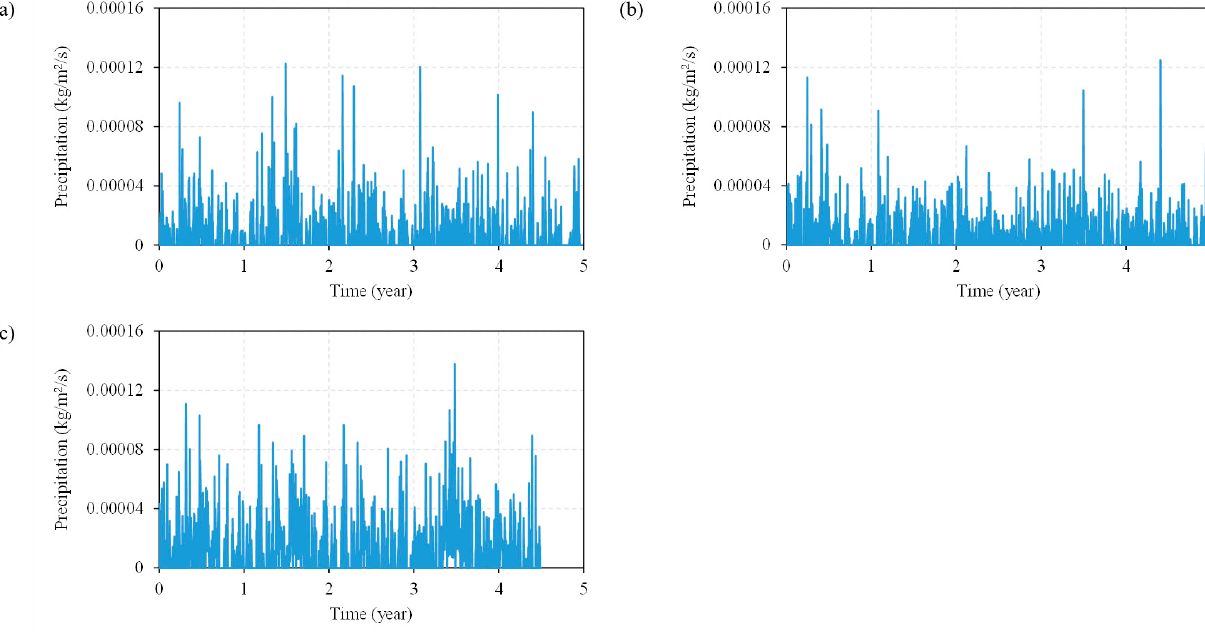
Figure 6. Examples of the mean precipitation: ( a ) BRU location ( b ) LT location ( c ) DP location.